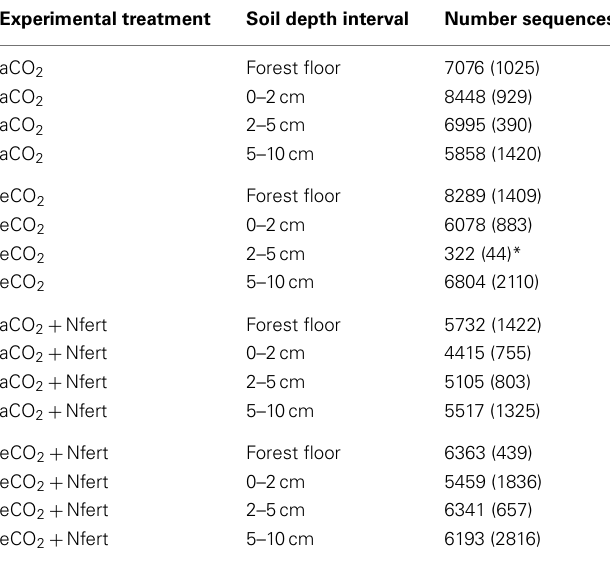
Table 3 |Average number of fungal LSU sequences, (followed by the standard deviation, n = 3), generated from each experimental